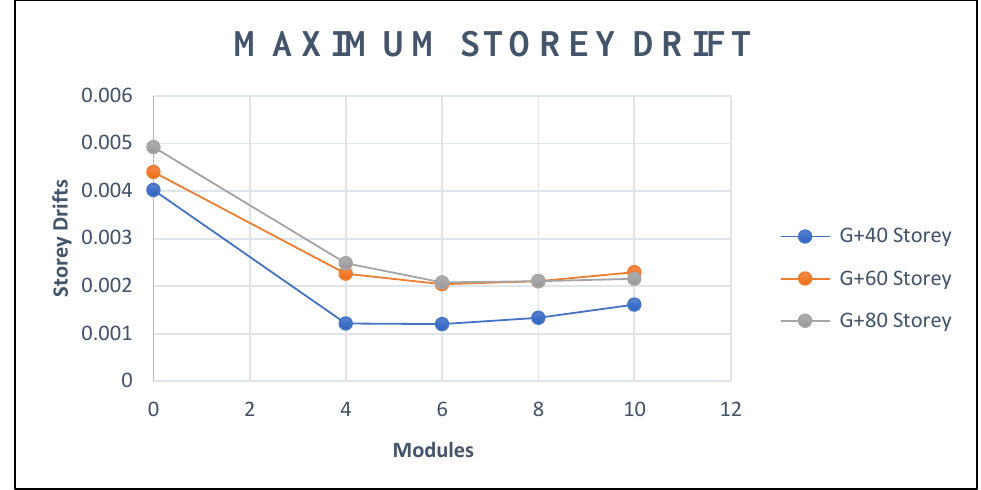
Fig. 5. Maximum Storey